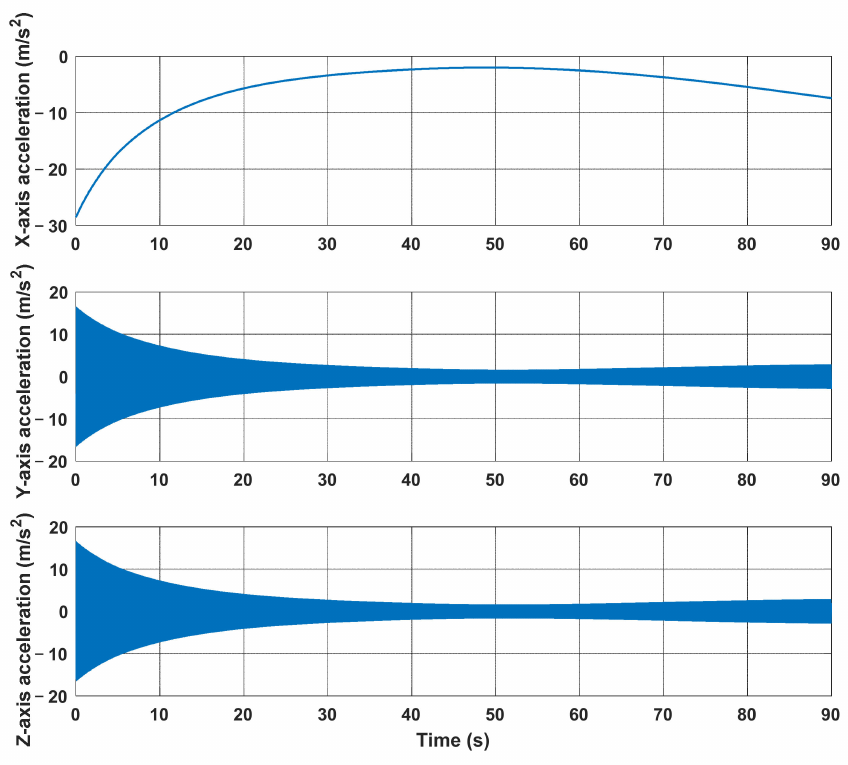
Figure 6. Three‑dimensional acceleration of